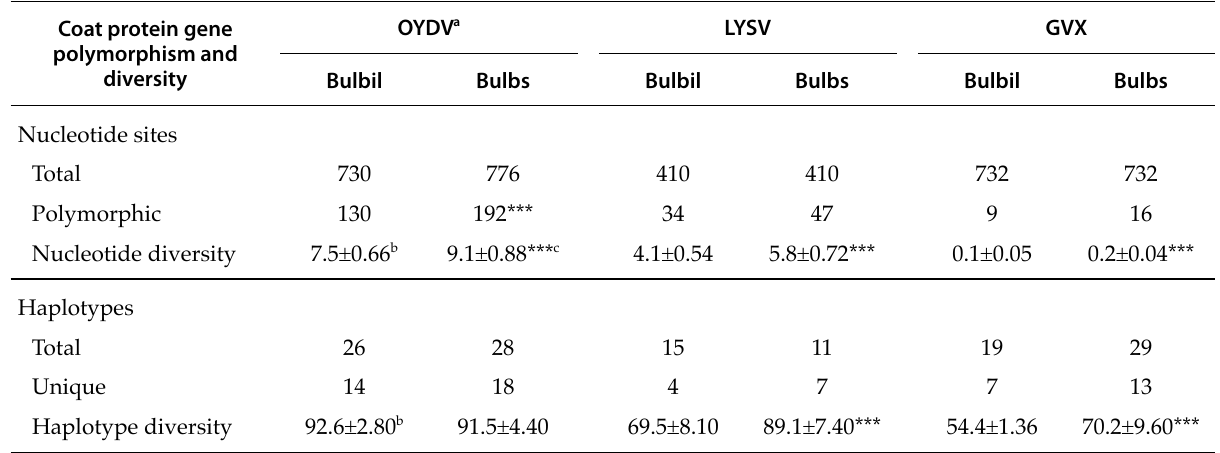
Table 3. Estimation of coat protein gene nucleic acid sequence polymorphism and diversity for detected allium viruses in garlic bulbils and